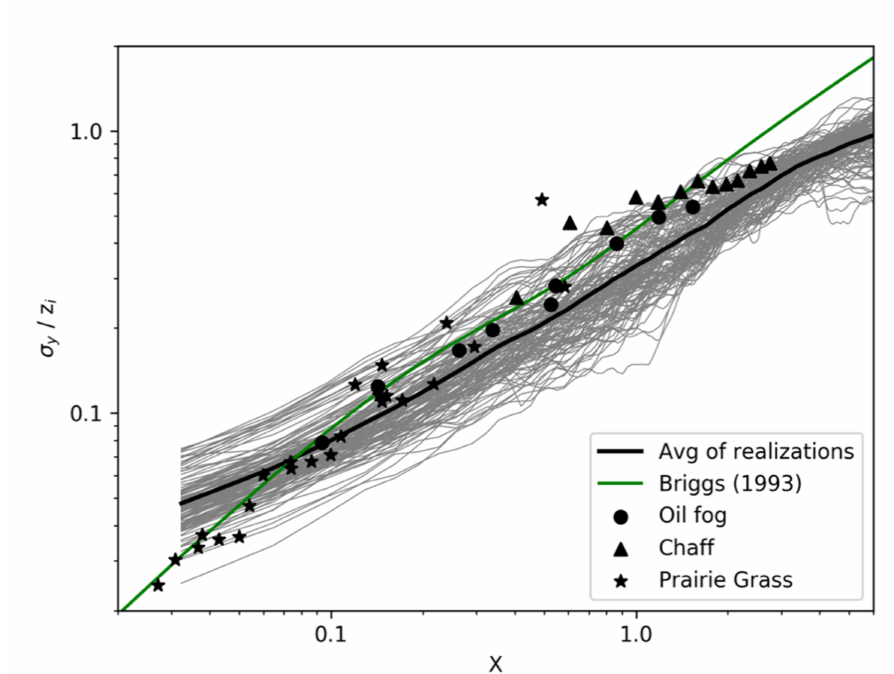
Figure 7. Surface crosswind dispersion from the GPU-LES model as a function of the downwind distance, compared to observations from the CONDORS field program. The gray lines depict a series of 30 individual realizations from the LES model. The black line represents the average of those realizations. The circles and triangles represent observations of normalized concentrations measured during the CONDORS and Prairie Grass experiments.